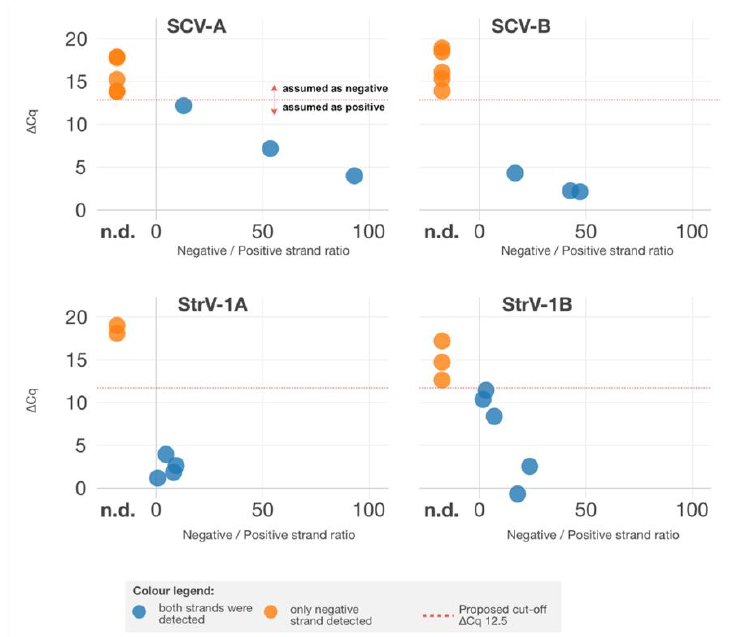
Figure 3. Comparison of ∆ C q values against ratios between negative and positive strands. Cases when only one, negative, strand was detected are annotated by an orange color and were aligned against the n.d. (not detected) sign on the abscissa